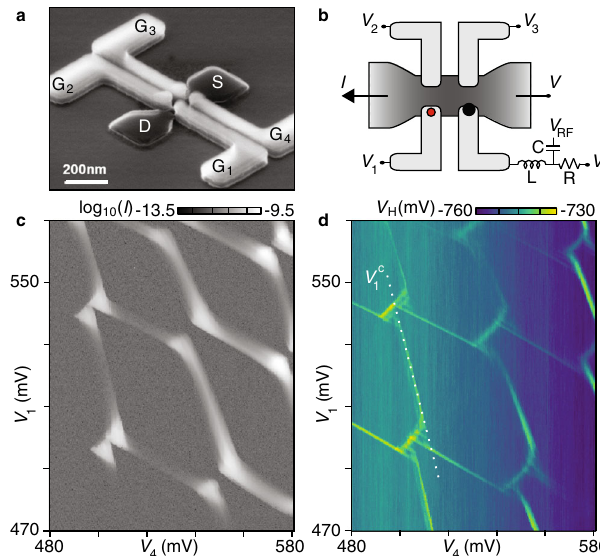
Fig. 1 Compensated control voltages within a two-dimensional silicon quantum-dot array. a Foundry-fabricated undoped silicon channel connected to reservoirs (dark gray), with four gate electrodes (light gray). backend 16 . b Device schematic for the example of a few-electron double dot underneath gates G 1 and G 4 , induced by appropriate control voltages V 1 – 4 . Each of the three qubit dots (dot 1 indicated in red) capacitively couples to the sensor dot (black), which can be monitored using RF re fl ectometry off an inductor (L) wirebonded to G 4 . c , d Charge stability diagram of